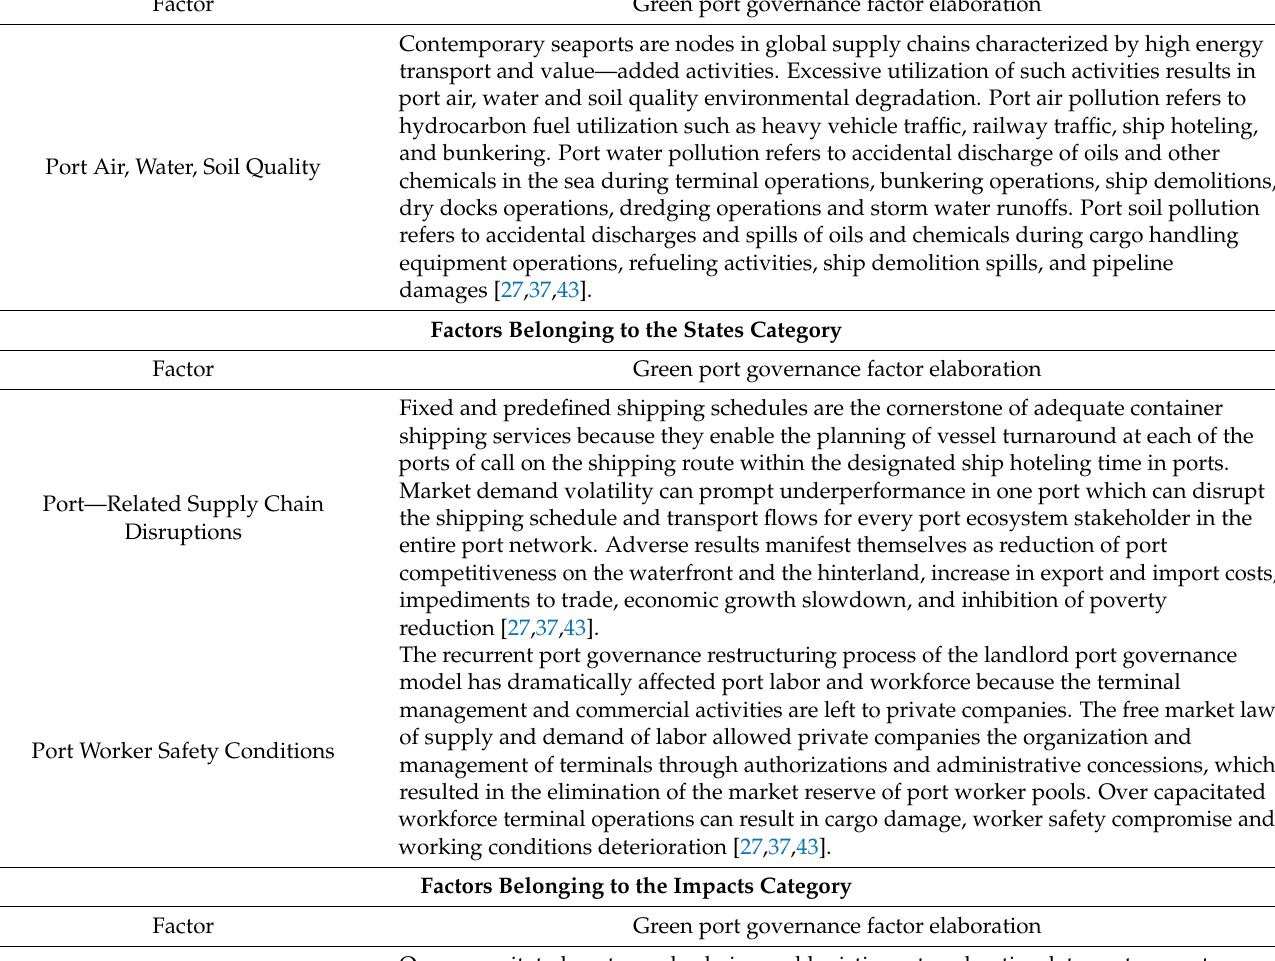
Table 7. Cont. Factors Belonging to the States Category Green port governance factor